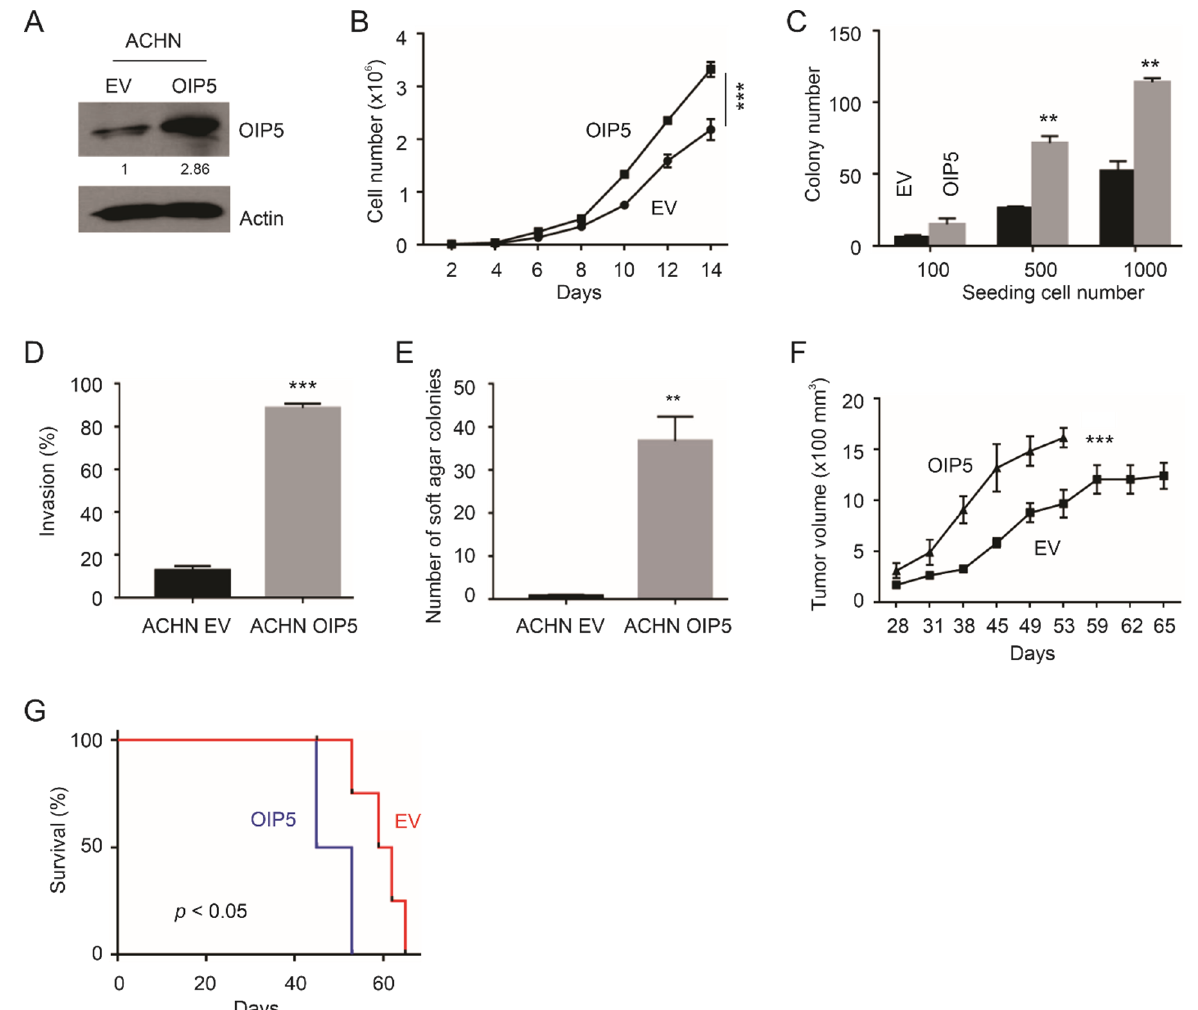
Figure 2. OIP5 promotes oncogenic processes of ACHN cells in vitro and in vivo. ( A ) ACHN empty vector (EV) and OIP5 stable lines. Western blot was carried out using anti-OIP5 and Actin antibodies. OIP5 expression was normalized to Actin and presented at fold changes to OIP5 expression in EV cells. ( B ) ACHN EV and ACHN OIP5 cells were seeded in 6-well plate at 10 5 cell/well; cell numbers were recorded at the indicated days. Experiments were repeated three times; means ± SDs are graphed. Statistical analysis was performed using 2-way ANOVA. ***: p < 0.001 between the two curves. ( C ) The indicated cells were seeded at the indicated number in 6-well plates. Colonies were formed following 2 weeks culture. Experiments were repeated three times; means ± SDs are graphed. **: p < 0.01 compared to the respective EV by Student’s t -test (2-way). ( D , E ) Invasion and soft agar assays were repeated 3 times; means ± SDs are graphed. **: p < 0.01, ***: p < 0.001 compared to the respective EV control by Student’s t -test (2-way). ( F , G ) Xenografts were produced in NOS/SCID mice (5 mice per group) using ACHN EV cells and ACHN OIP5 cells. Means ± SEM (standard error of the mean) are graphed; ***: p < 0.001 between the two curved by two-way ANOVA ( F ). Kaplan-Meier curve; statistical analysis was performed using logrank test ( G